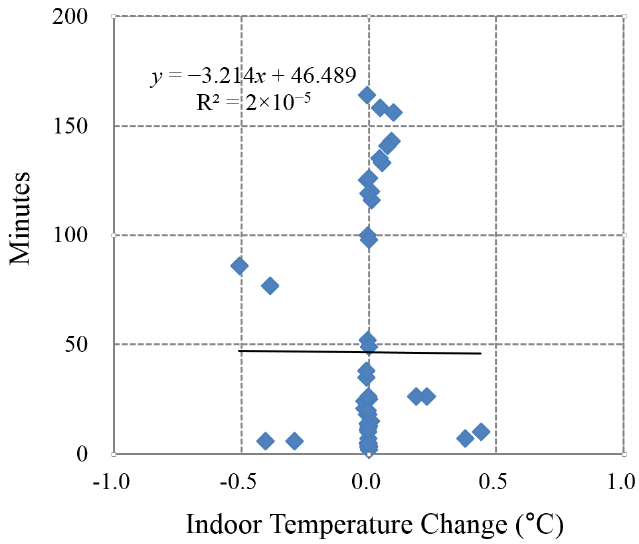
Figure 9. Relationship between the indoor temperature change ( Δ TEMP IN ) and the required minutes for restoring from the current temperature to the normal set-point